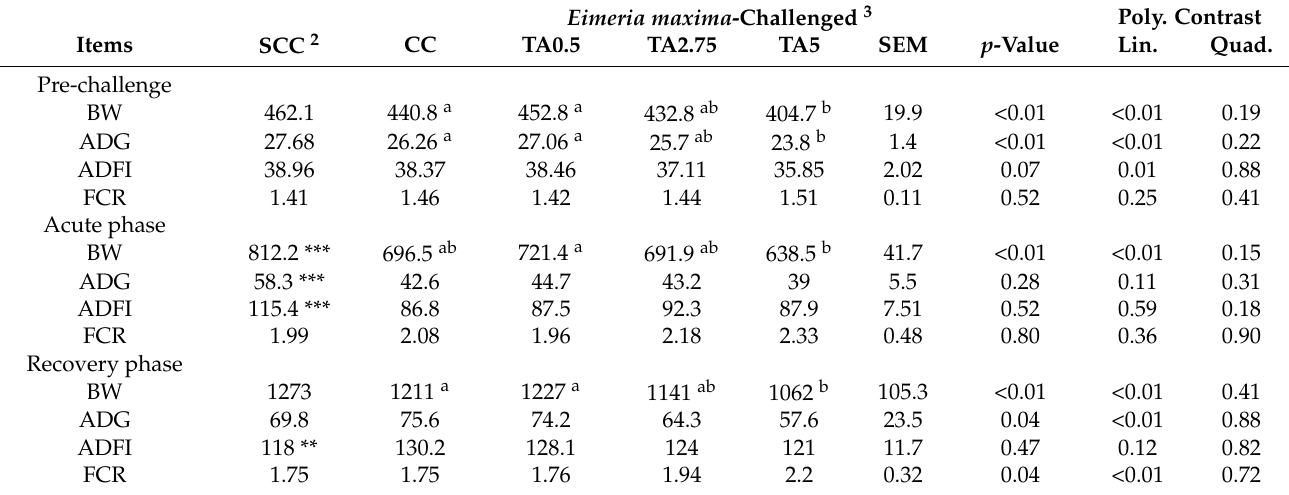
Table 3. Effects of tannic acid supplementation on growth performance parameters including body weight (BW, g), average daily gain (ADG, g/d), average daily feed intake (ADFI, g/d), and feed conversion ratio (FCR, g/g) of broilers infected with Eimeria maxima during the pre-challenge period (D 0 to 15), acute phase: 0 to 6 days post-infection (dpi), and recovery phase: 6 to 13 dpi 1 . Eimeria maxima -Challenged 3 Poly.